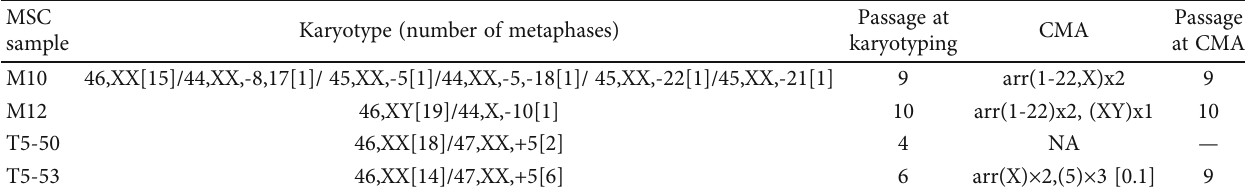
Table 1: Cytogenetic characterization by karyotype and CMA of human bone marrow MSC samples included in the study. MSC Karyotype (number of metaphases) sample